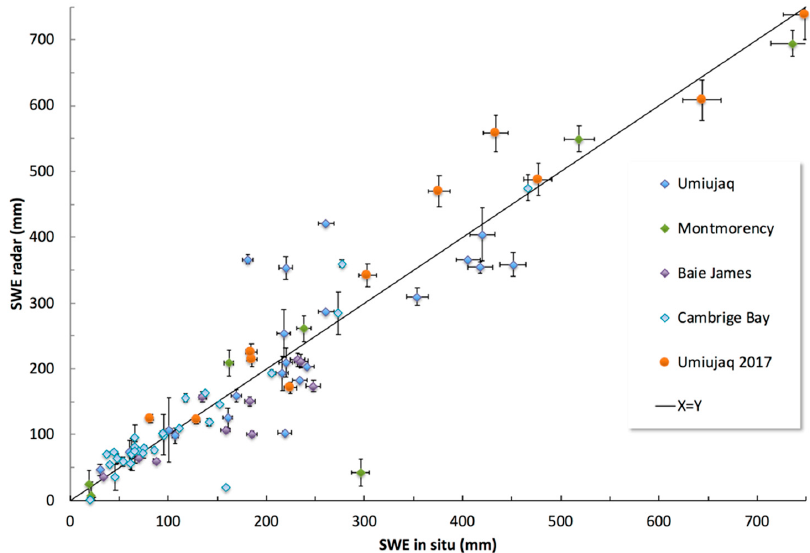
Figure 13. Radar-based automatic SWE estimates used with a snow depth probe compared to in situ SWE measurements (snowpit) from five field campaigns in North-Eastern Canada over dry snowpack.